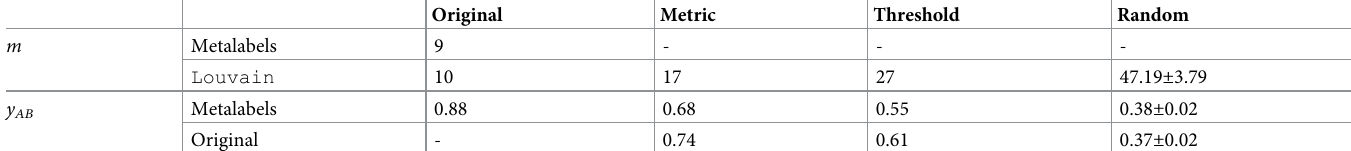
Table 2. SocioPatterns Fr-HS contact network and its community structure detected by the Louvain algorithm [49] for the original (proximity) network and several of its subgraphs. Top rows ( m ) show the number of distinct metalabels and the number of communities detected, while bottom rows show the bidirectional modularity similarity, y (Eq 8 in Section 4.2). Columns show values for original graph, metric backbone subgraph, and same-size threshold and random subgraphs. Mean and stan- AB dard deviation shown for 100 random subgraphs.